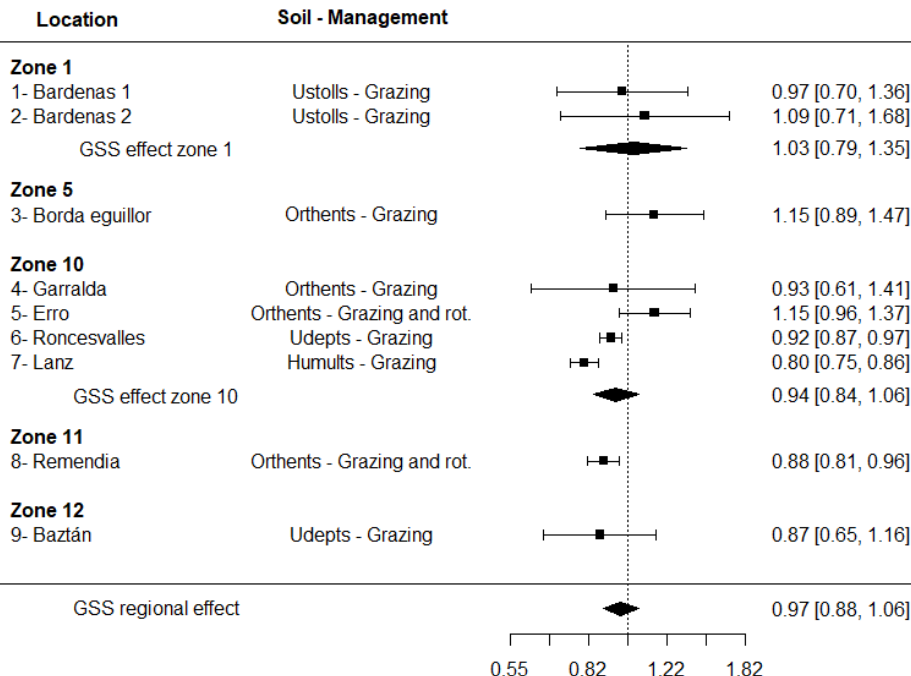
Figure 15. Response ratio (RR) of AWHC (0–30 cm) for the adaptive management strategy of controlled grazing and/or rotation in grasslands (GSS). Zones correspond to those in Figure 1. The effect was considered significant when the 95% confidence interval (CI) of the RR did not overlap one ( α = 0.05). Soil and management column includes information about principal soil group and management considered in each group.